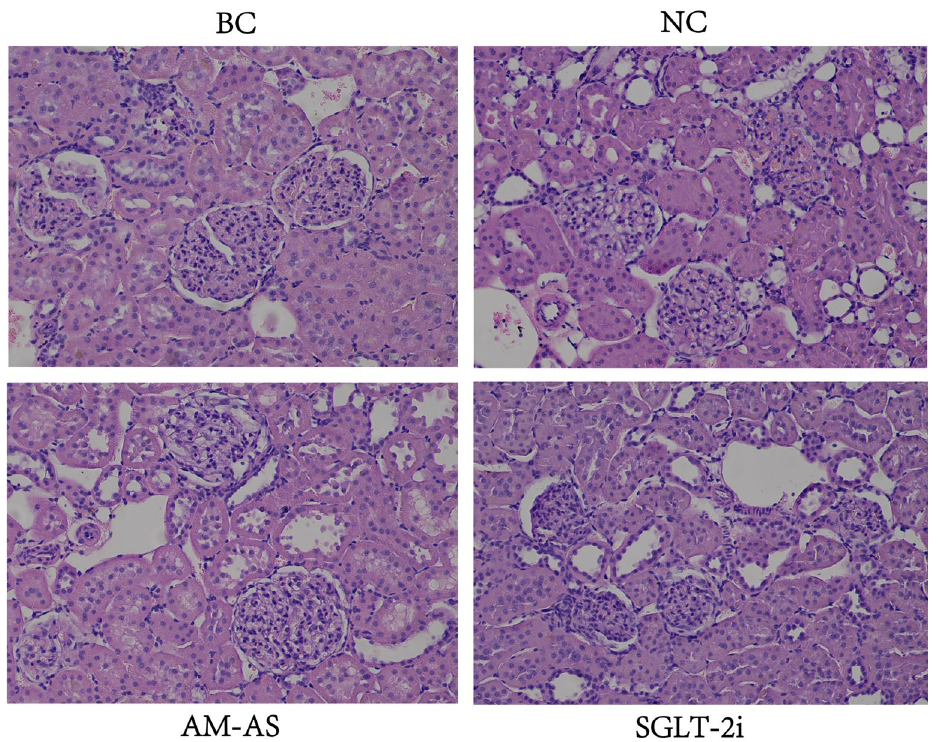
Figure 10. Renal tissue cells of rats (HE ×